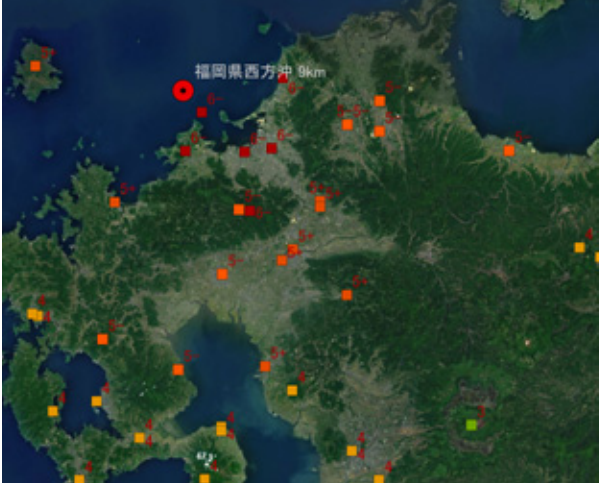
Figure 6. Earthquake scene on GIS system